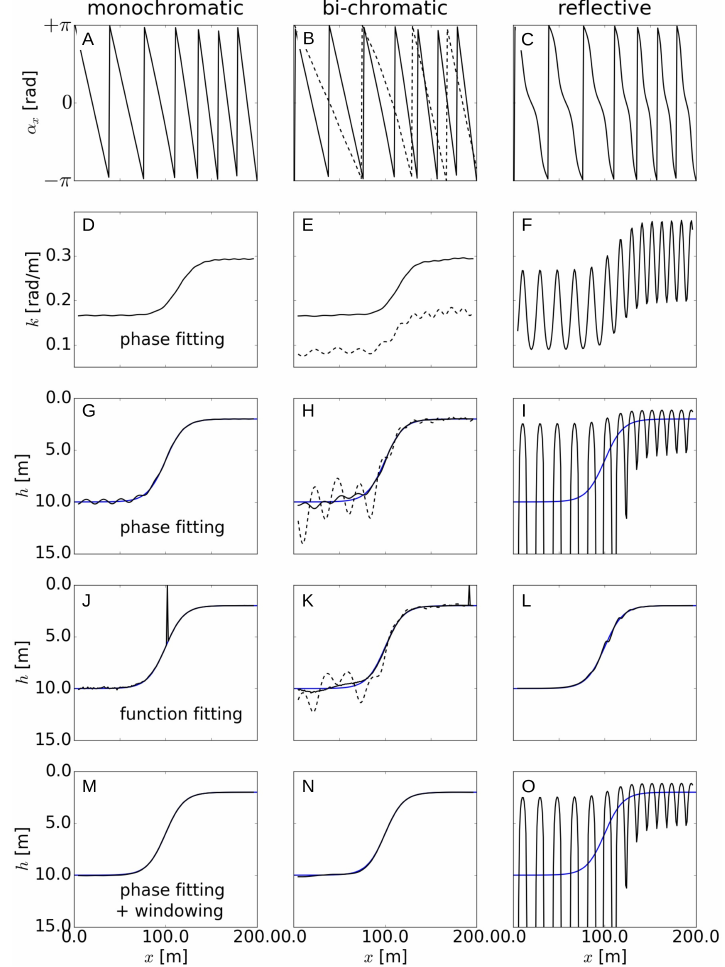
Figure 2. Angle of the Empirical Orthogonal Function (( A – C ), wavenumber from phase fitting D – F ), depth from phase fitting ( G – I ), function fitting ( J – L ), and windowing ( M – O , with w t = 40 s) for each of the monochromatic, bichromatic, and reflective 1D cases: First (second) mode is in solid (dashed) lines. Blue lines are for the exact